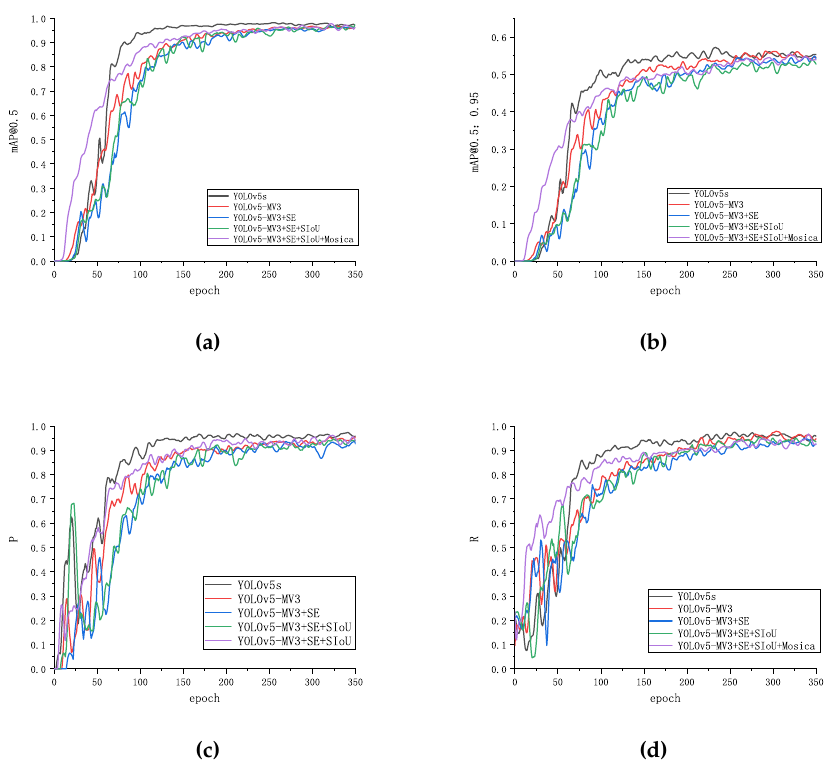
Figure 9. Results of different models for training. ( a ) mAP (0.5) curves of different model; ( b ) mAP (0.5:0.95) curves of different model; ( c ) precision curves of different model; ( d ) recall curves of different model. Table 3. Results of ablation